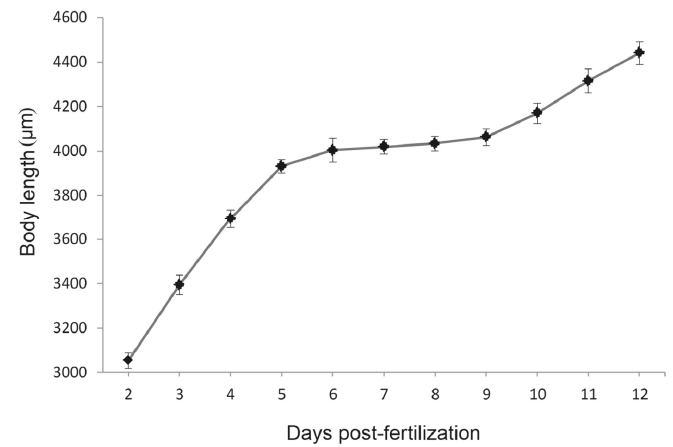
Figure 7. The drawing of growth trends from 2 days post fertilization (dpf) to 12 dpf. Data from body length are shown as mean ± standard deviation ( n = 30).